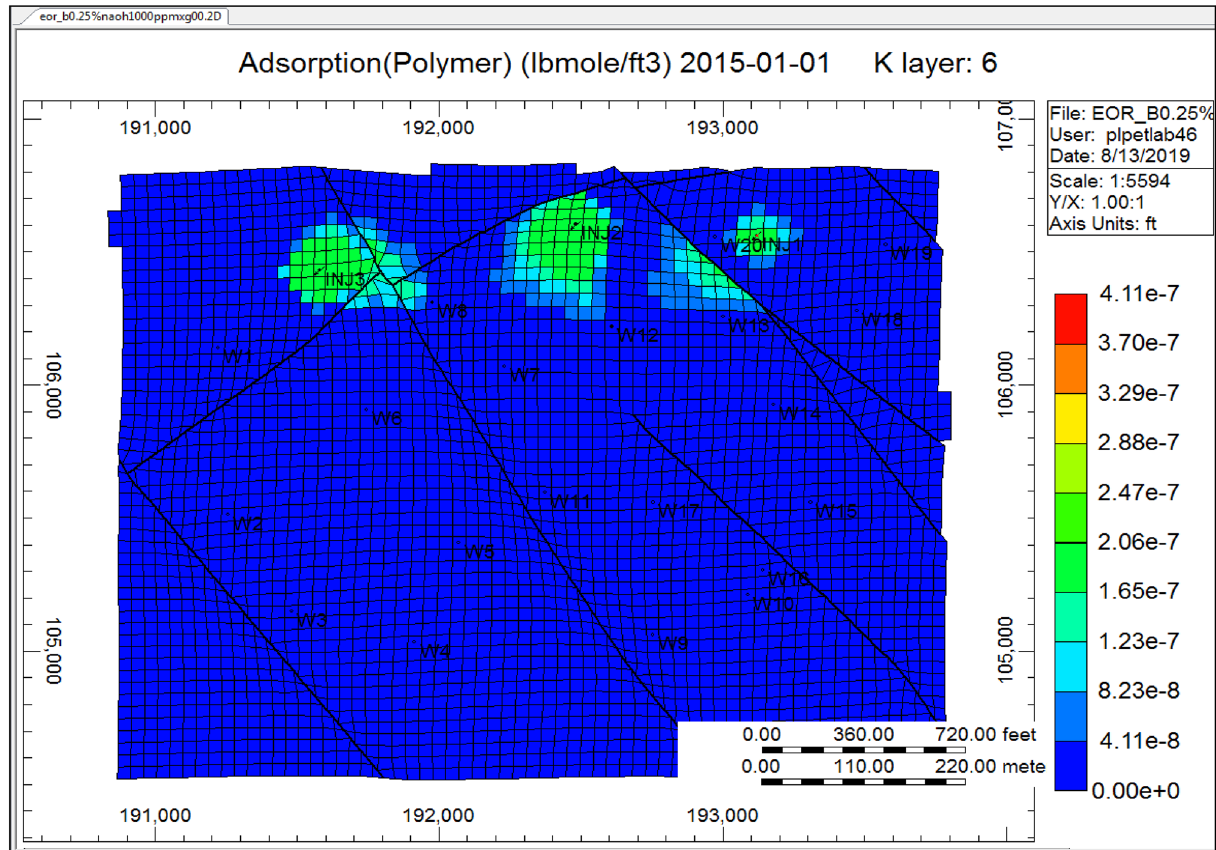
Fig. 11 Adsorption of 1000 ppm Polymer with 0.25%